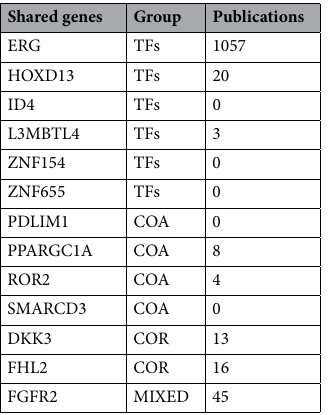
Table 2. Number of publications addressing the top altered genes in both the TCGA and MSKCC cohorts. The genes were mined in PubMed using the following search term (prostate cancer [Title/Abstract]) AND gene name [Title/Abstract]).